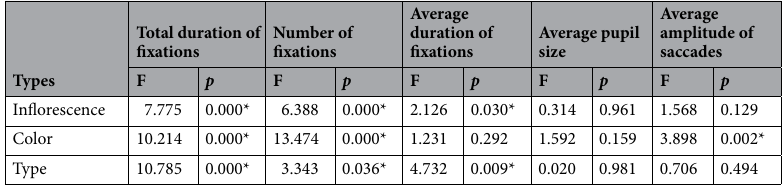
Table 6. ANOVA results of eye movement indexes of different types of flowers. *Indicating that there is a difference in the index of this